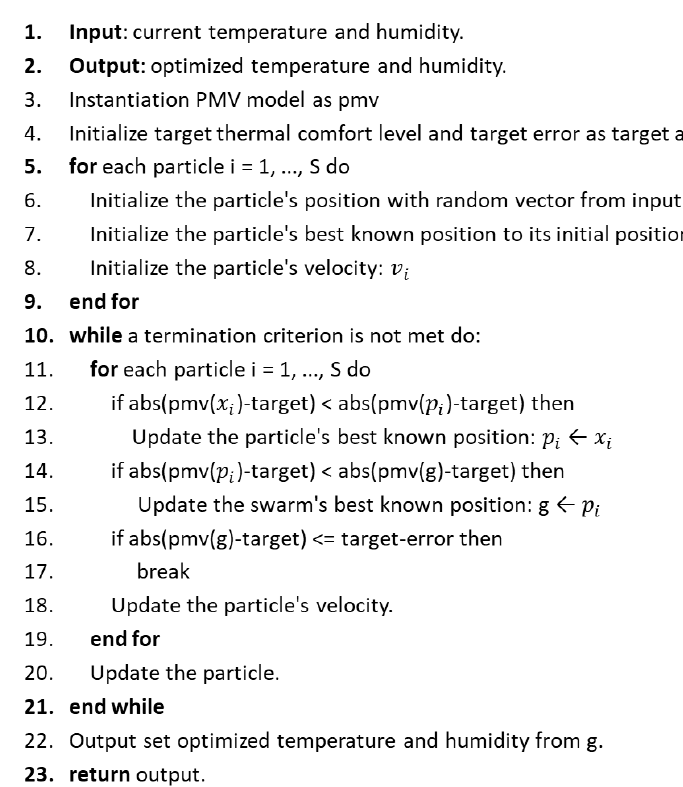
Figure 3. PSO Algorithm of PMV based Optimization Scheme.